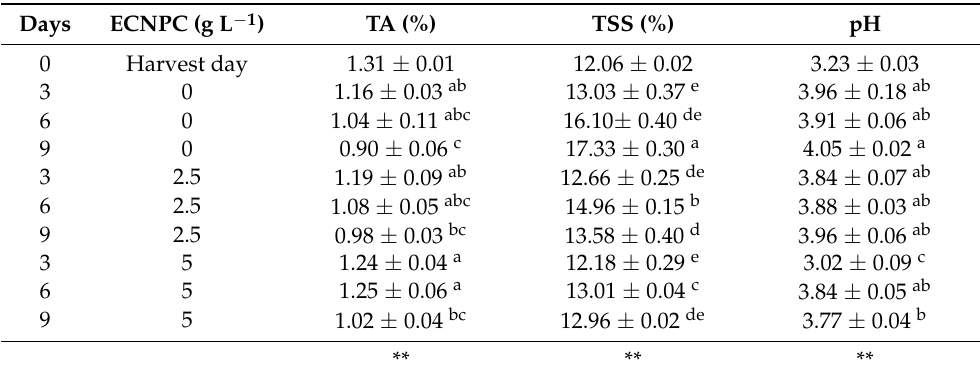
Table 1. Effect of different chitosan nano-emulsion treatment on the quality attributes of raspberry at harvest and in storage time at 4 ± 1 ◦ C.